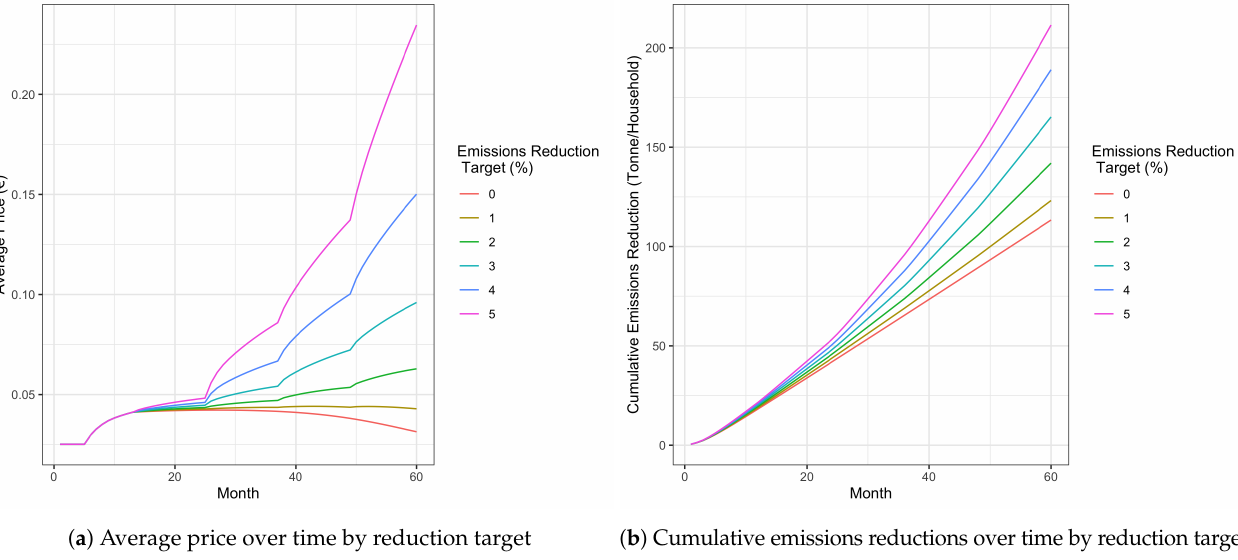
the cumulative emission reductions. The results make clear that choosing the target is an influential policy adjusting screw. In later time steps, in particular, the decreasing allocation of allowances results in an increasing price and higher emission